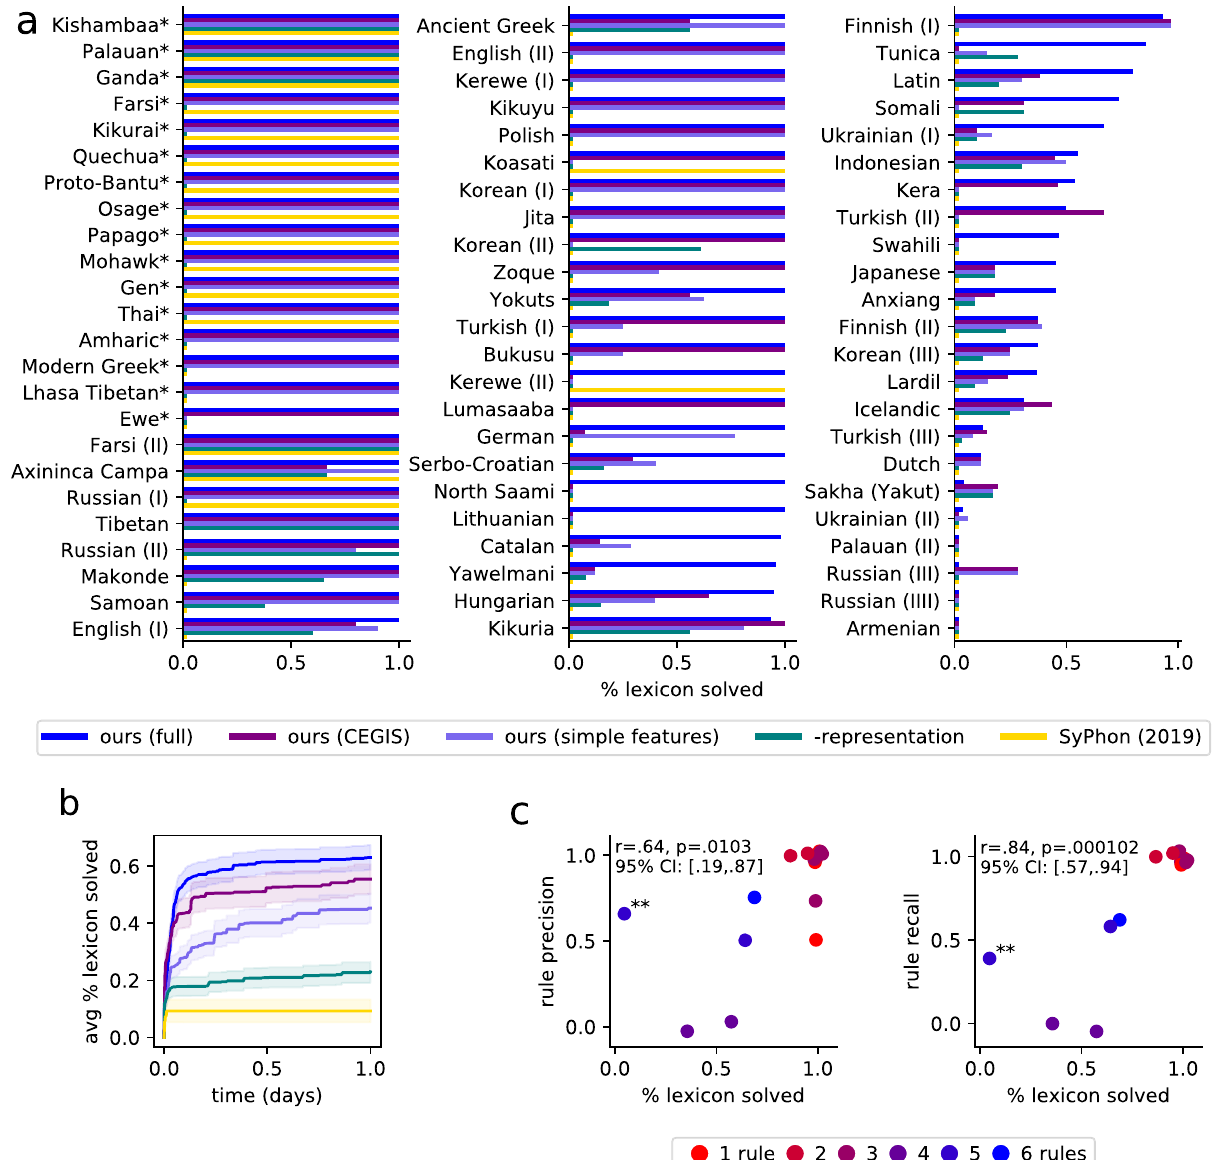
Fig.5|Modelsappliedtodatafromphonologytextbooks.a Measuring%lexicon solved,whichisthepercentageofstemsthatmatchgoldground-truthannotations. Problems marked with an asterisk are allophony problems and are typically easier. For allophony problems, we count % solved as 0% when no rule explaining an alternation is found and 100% otherwise. For allophony problems, full/CEGIS models are equivalent, because we batchthe fullproblem at once(Supplementary Methods 3). b Convergence rate of models evaluated on the 54 non-allophony problems. All models are run with a 24-h timeout on 40 cores. Only our full model can best tap this parallelism (Supplementary Methods 3.3). Our models typically converge within a half-day. SyPhon 36 solves fewer problems but, of those it does